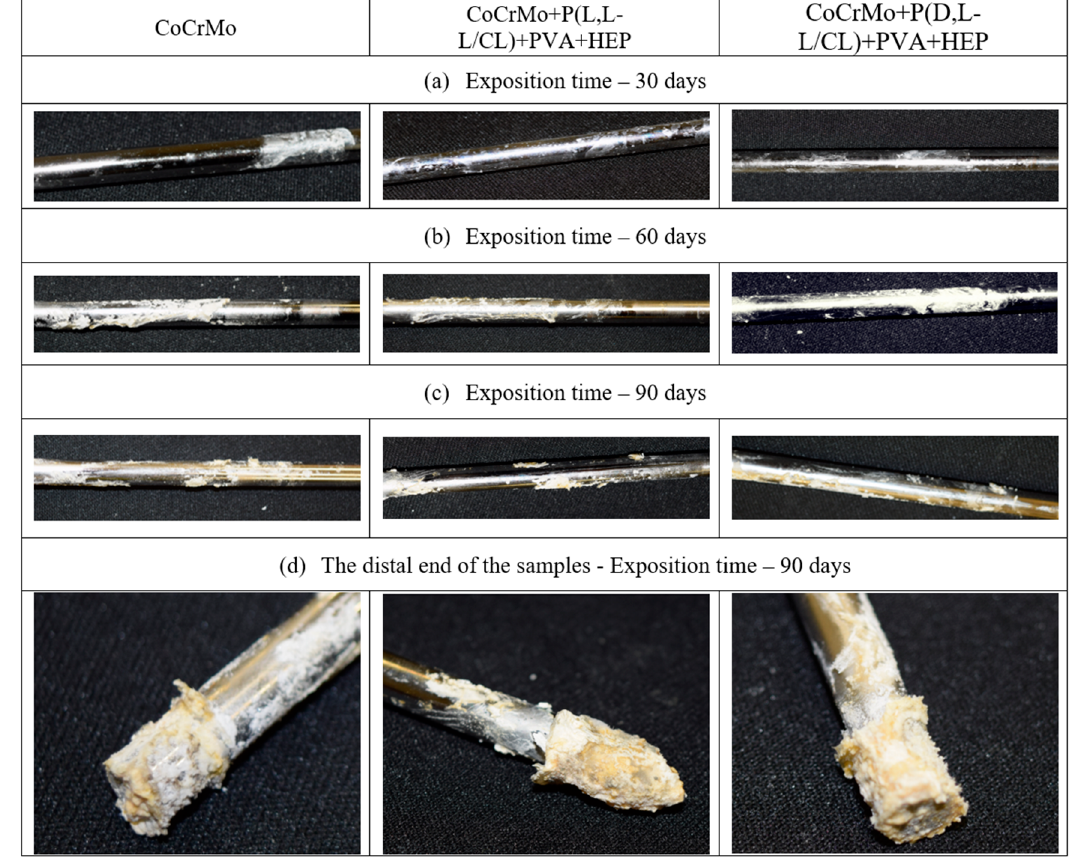
Figure 10. Examples of surfaces of test specimens with visible incrustation after 30, 60, and 90 days of exposure to artificial urine. Samples after exposition: ( a ) 30 days; ( b ) 60 days; ( c ) 90 days ; ( d ) 90 days—distal end of the samples.